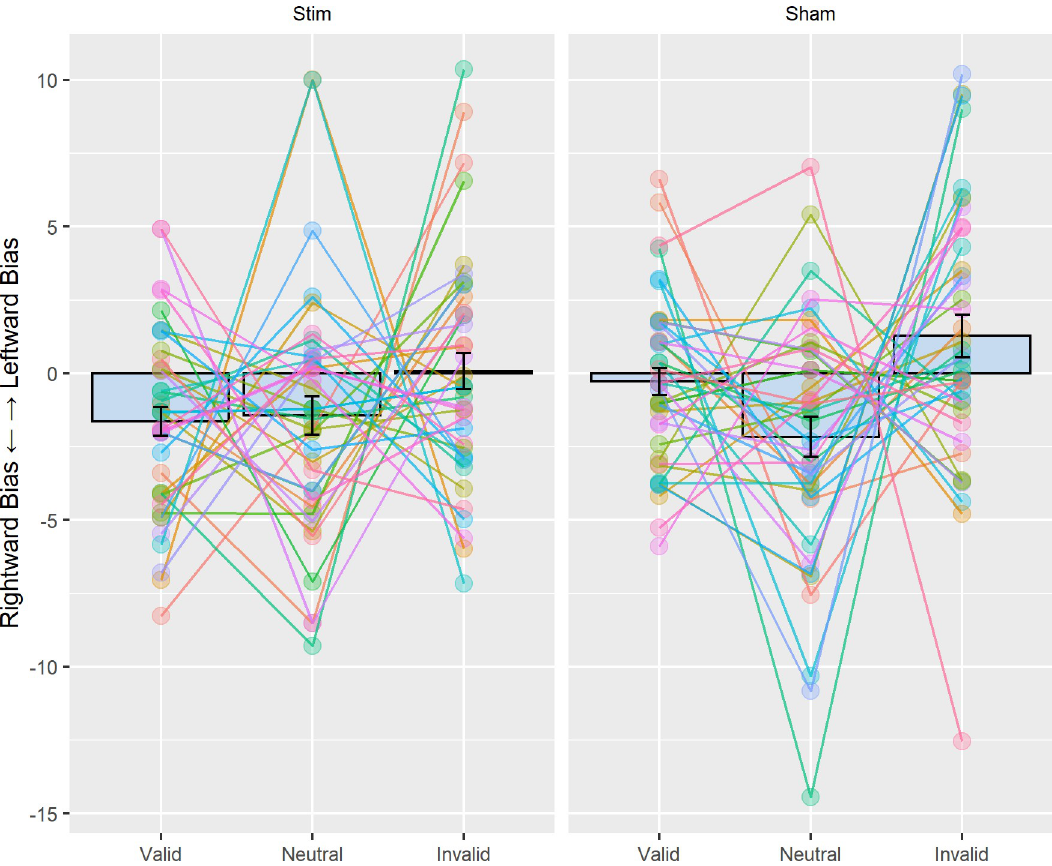
Fig 5. Accuracy. The average accuracy for each condition superimposed with individual data points of each participant. Error bars represent 95% confidence interval corrected for a within subjects design [46]. A positive value of the measure of bias in accuracy indicates a leftward bias (i.e. increased accuracy in the left hemifield), and a negative value indicates a rightward bias (i.e. increased accuracy in the right hemifield).